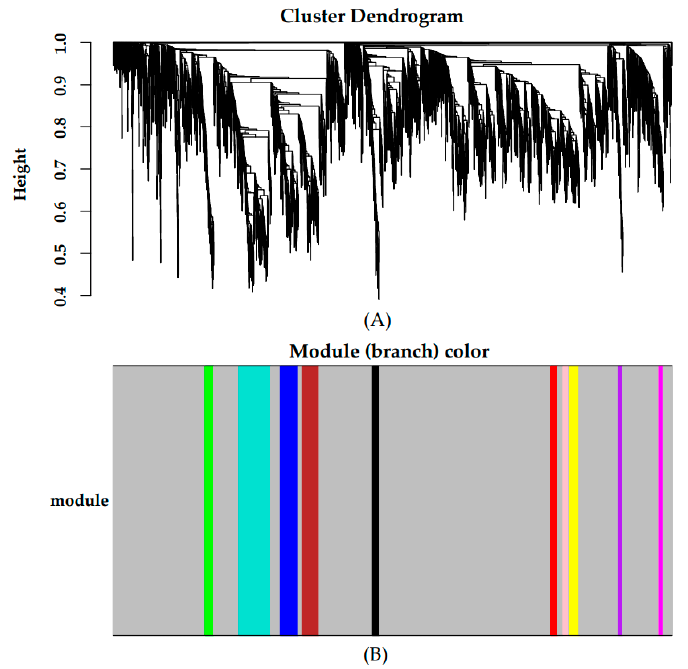
Figure 2. Gene cluster dendrograms and module detecting. ( A ) Clustering of genes based on the topological overlap. ( B ) The merged modules with similar expression patterns.